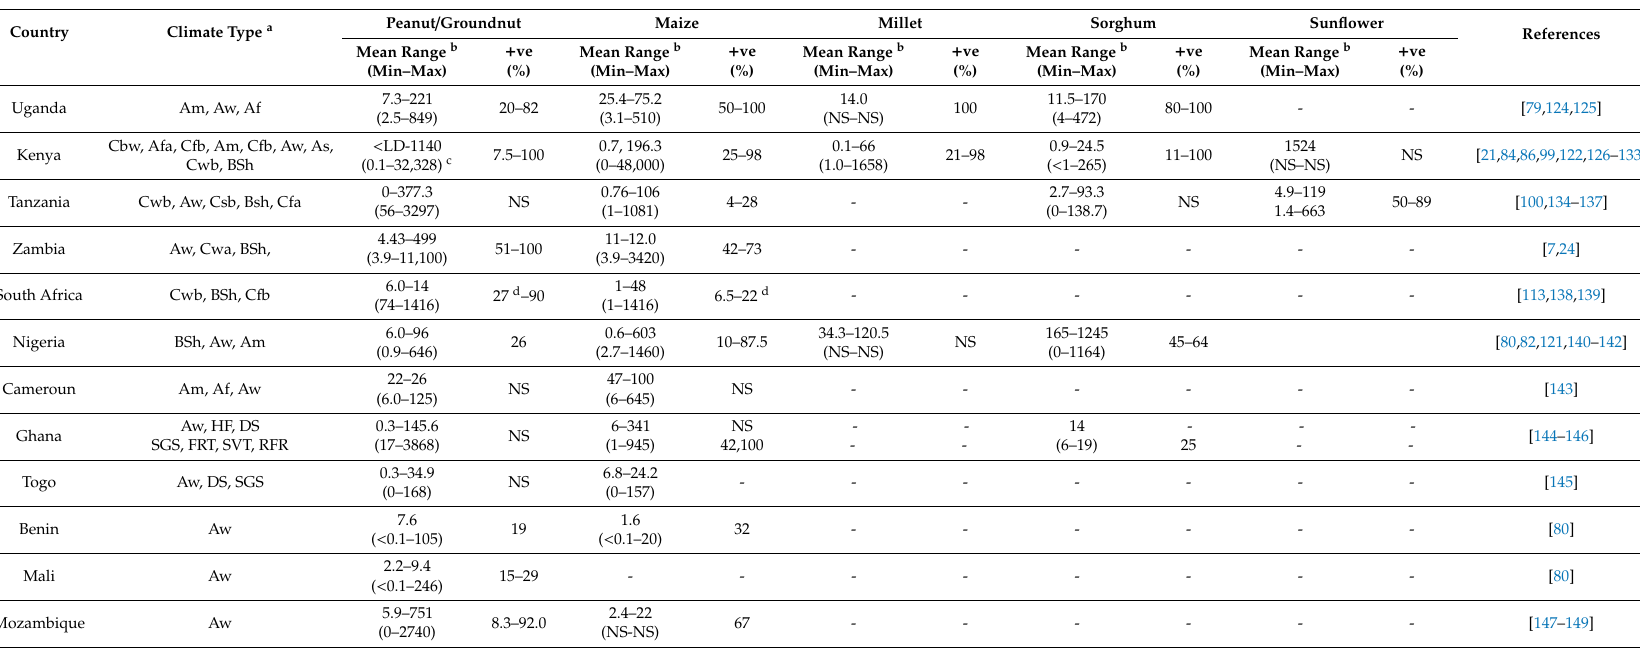
Table 5. Incidence (%) and concentrations ( µ g / kg) of aflatoxins in staple agricultural products of selected countries from Sub-Saharan Africa. Data are for total aflatoxins (B1 + B2 + G1 + G2), unless otherwise stated in the footnotes of Supplementary Material Tables S2 and S3. / Groundnut Maize Country Climate Type a Peanut